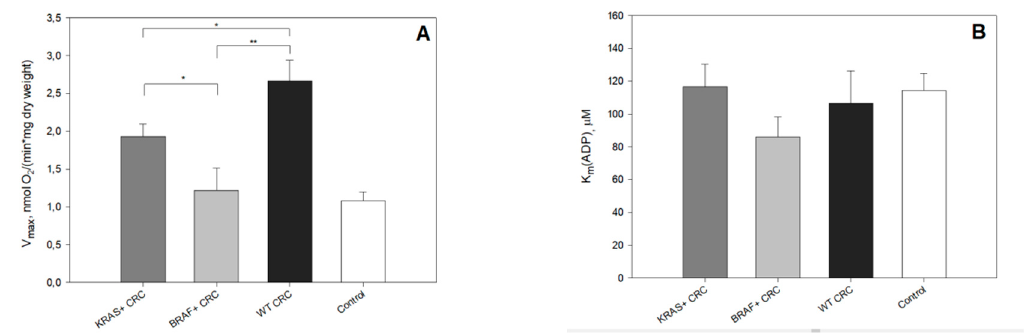
Figure 1. Regulation of mitochondrial respiration in KRAS + , BRAF + and wild-type tumors and control. ( A ) Comparative analysis of maximal ADP-activated respiratory rate (V max ) and ( B ) the apparent Michaelis–Menten constant (K m (ADP)) values for ADP. KRAS + : KRAS mutated; BRAF + : BRAF mutated; WT: wild type; CRC: colorectal cancer; Control: control tissue. * p < 0.05; ** p < 0.01.